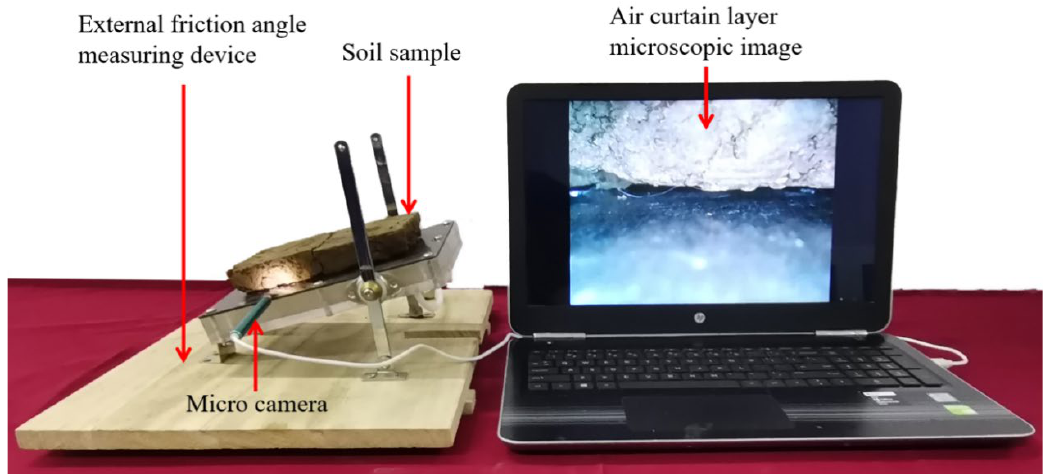
Figure 3. Experimental process captured by a microscopic camera.